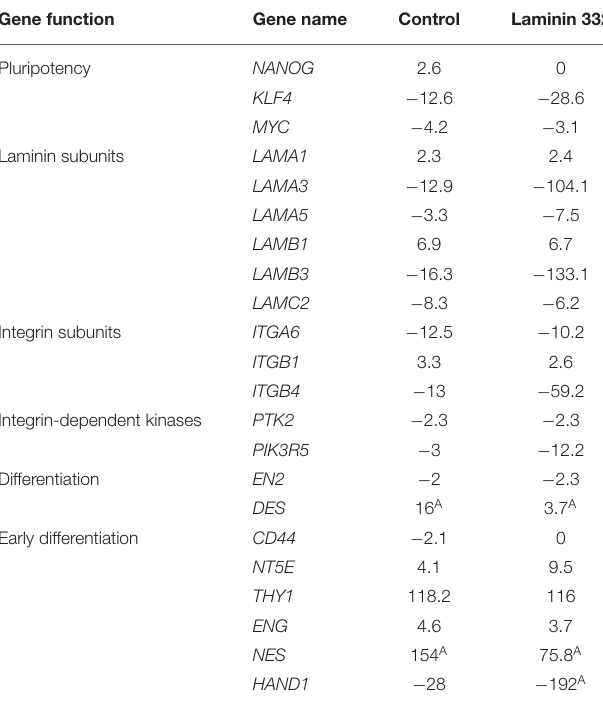
TABLE 5 | Summary of significant effects of LN-332 on proliferative activity and specific markers of pluripotency, adhesion, immunomodulation and differentiation.